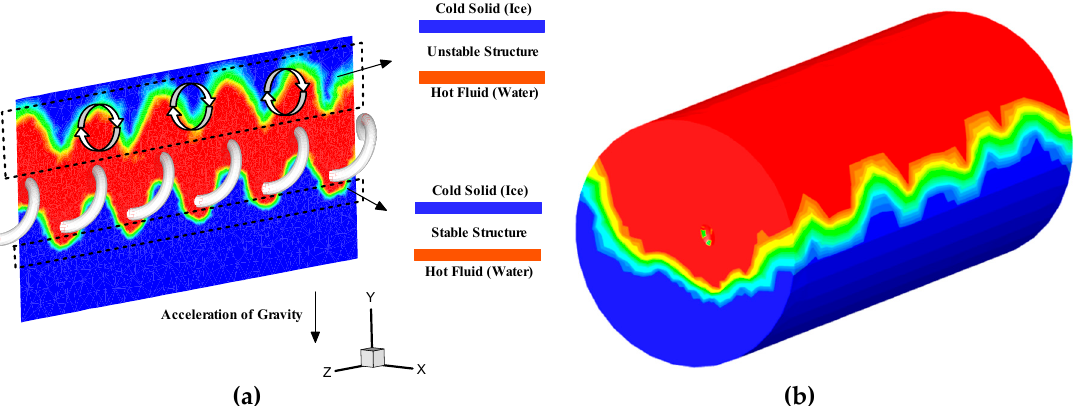
Figure 7. Stable and unstable structures of thermal layers developed around the coil tube for T inlet = 5 . 5 ◦ C and V = 4 L / min at t = 250 min ( a ) and 500 min ( b ).